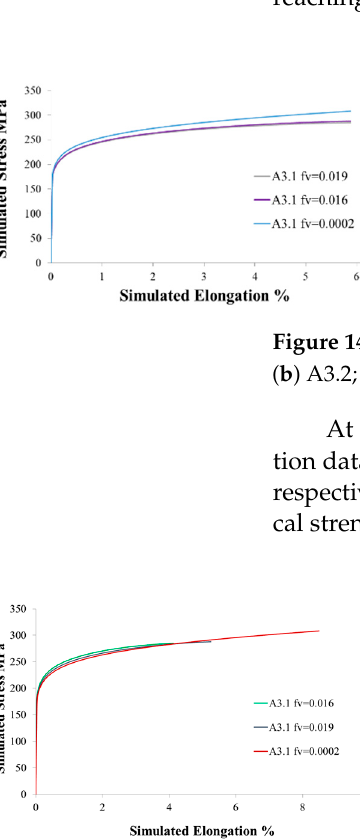
Table 9. Comparison of Calculated and Tested Tensile Test Values in 1 mm/min Stroke Speed.